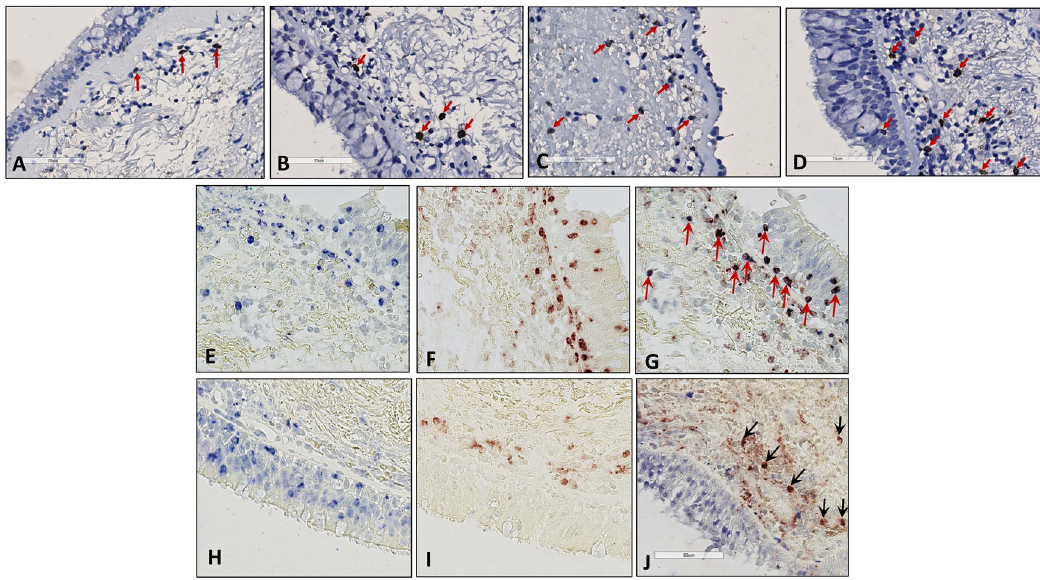
Fig 4. IL-17 expression in the submucosa of bronchial biopsies of 4 groups of studied population. atopic inhaled corticosteroid (ICS) user (frame A), nonatopic ICS user (frame B), atopic non-ICS user (frame C), nonatopic non-ICS user (frame D). Single staining for IL-17 (frame E; blue) and MPO (frame F; red) and double staining for IL-17 and MPO (frame G; purple) in adjacent sections of a nonatopic non-ICS user asthmatic patient. Single staining for IL-17 (frame H; blue) and EPX (frame I; red) and double staining for IL-17 and EPX (frame J; purple) in adjacent sections of an atopic non-ICS user asthmatic